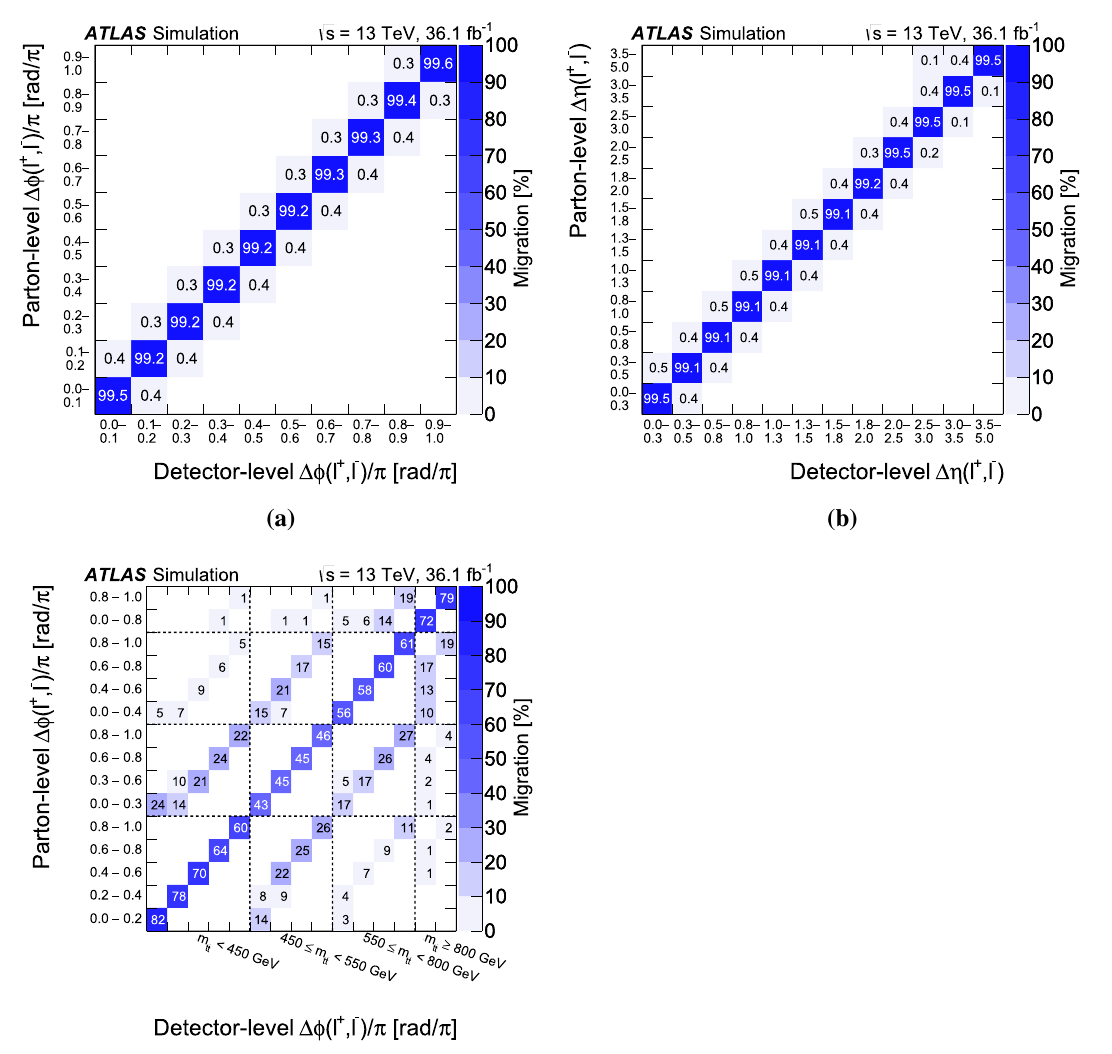
axes is identical, with each invariant mass region subdivided into (cid:3)φ bins. The dotted lines separate different invariant mass regions, while the tick marks indicate the (cid:3)φ